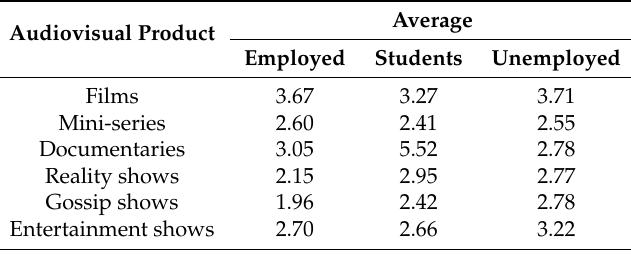
Table 14. Audiovisual products consumption according to occupation